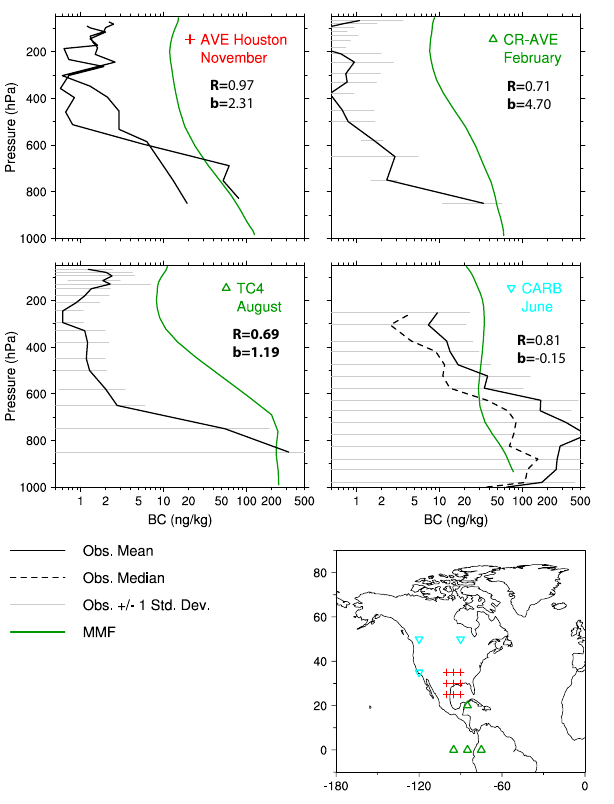
Fig. 15. BC vertical profiles in the tropics and middle latitudes over 4 different campaigns (AVE Houston: NASA Houston Aura Val- idation Experiment; CR-AVE: NASA Costa Rica Aura Validation Experiment; TC4: Tropical Composition, Cloud and Climate Cou- pling; CARB: NASA initiative in collaboration with California Air Resources Board). Monthly mean model profiles are averaged over the points in the map. Observations are average for the respective campaigns and are measured by three different groups: the NASA group (Schwarz et al., 2006) for AVE-Houston, CR-AVE, and TC4; the University of Tokyo group (Moteki and Kondo, 2007; Moteki et al., 2007) for CARB; and the University of Hawaii group (Clarke et al., 2007; Howell et al., 2006; McNaughton et al., 2009; Shinozuka et al., 2007) for CARB. The Houston campaign has two profiles measured two different days. See Table 7 in Koch et al. (2009) for flight details. Normalized model mean bias (b) and the correlation coefficient between the model and observations (R) are shown in each panel. Values of b and R are calculated using observed values provided at discrete altitudes and model values interpolated from model grid to those altitudes.